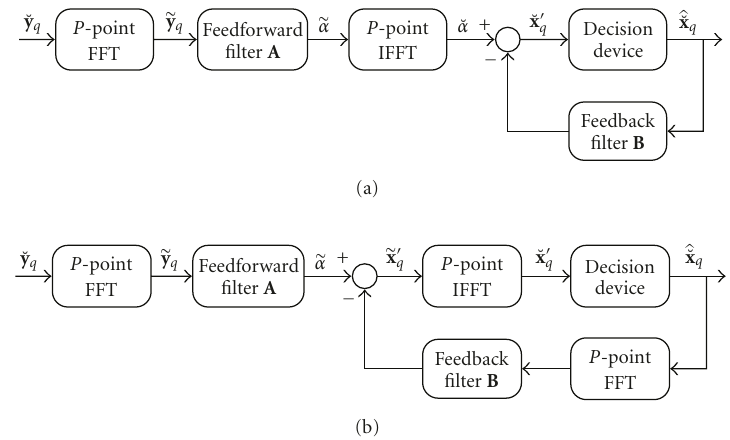
Figure 2: Decision feedback detector for Q-OFDMA systems: (a) hybrid domain DFE, and (b) frequency domain DFE.